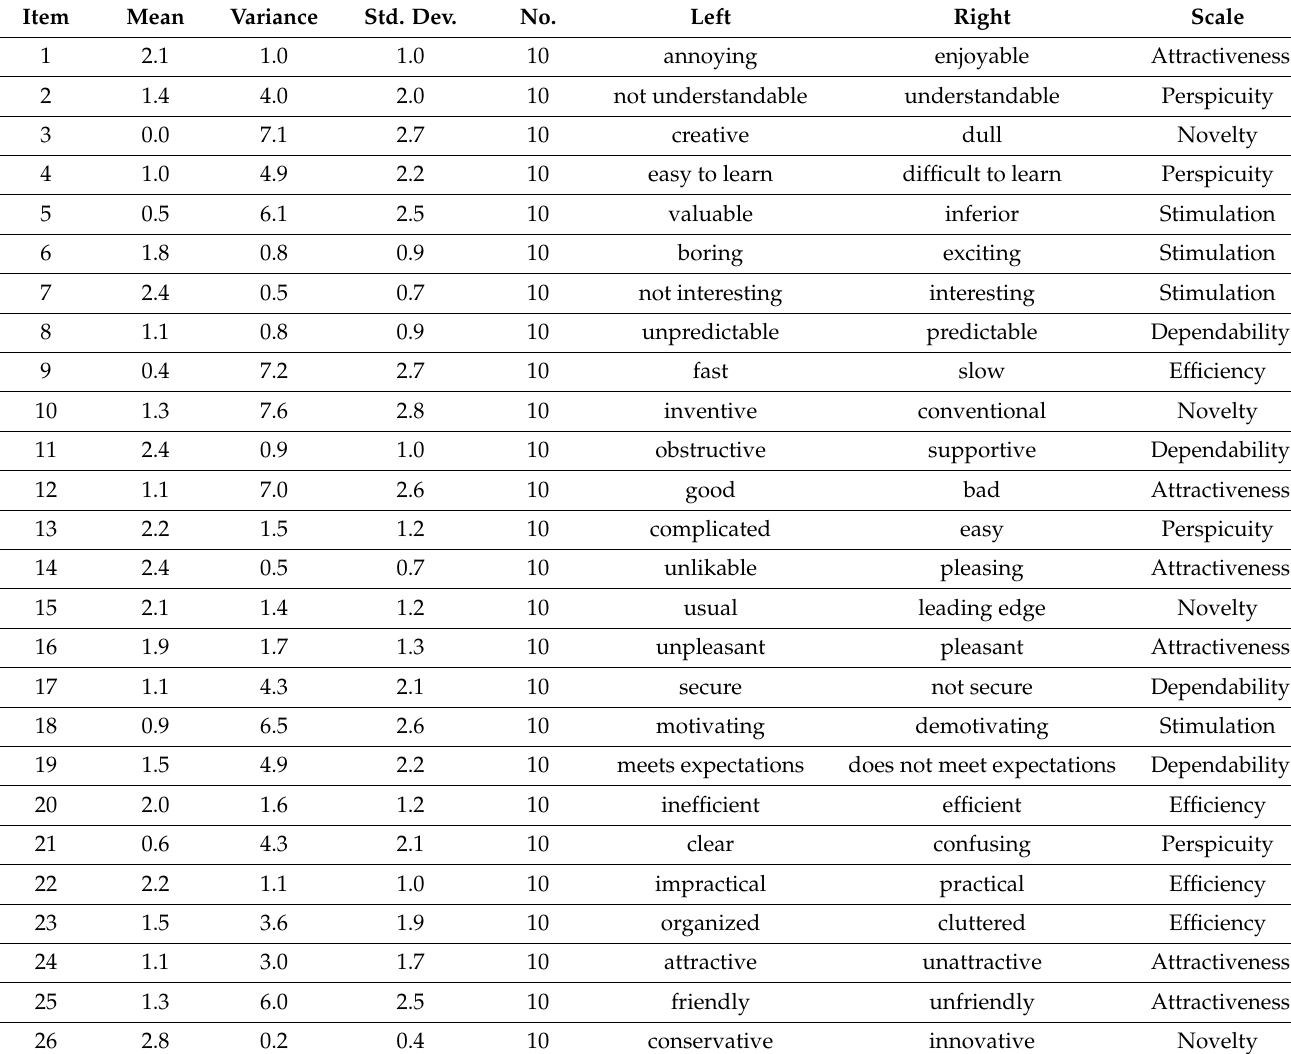
Table 5. Summary of external users’ responses to the UEQ.